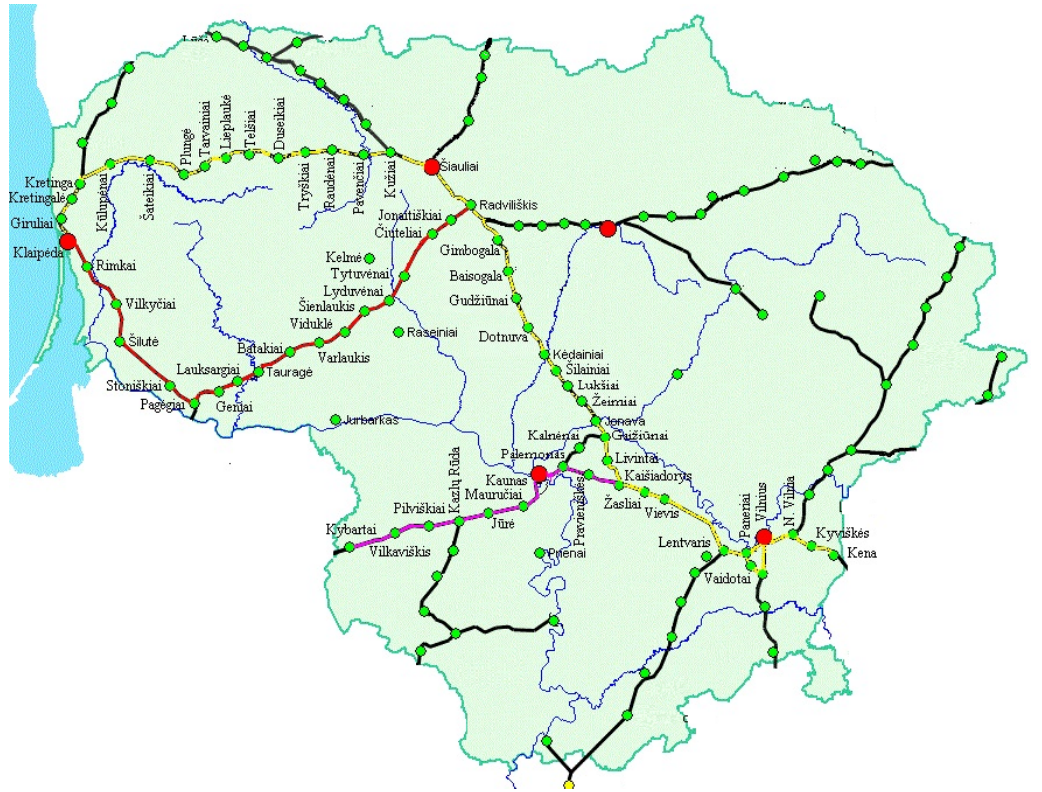
Fig. 2. Lithuanian railway lines (Parovoz IS